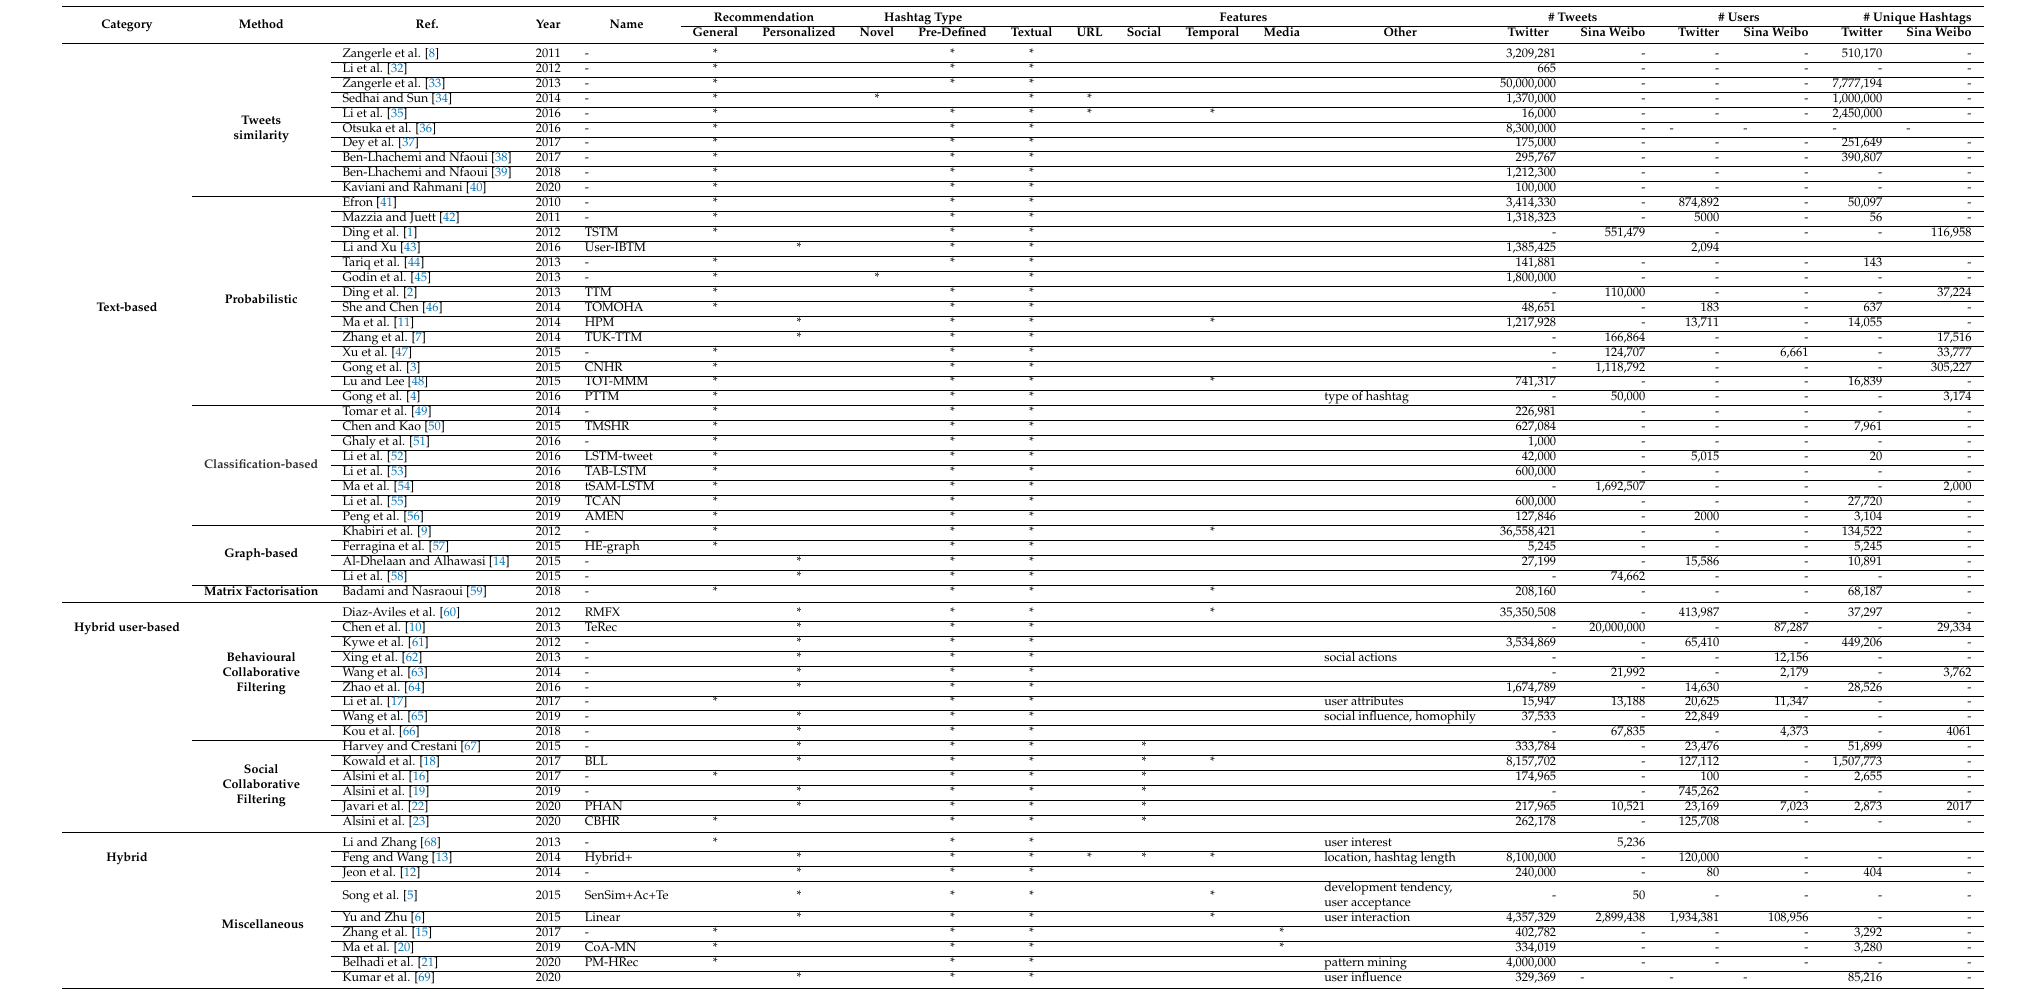
Table 1. Summary of the 61 eligible